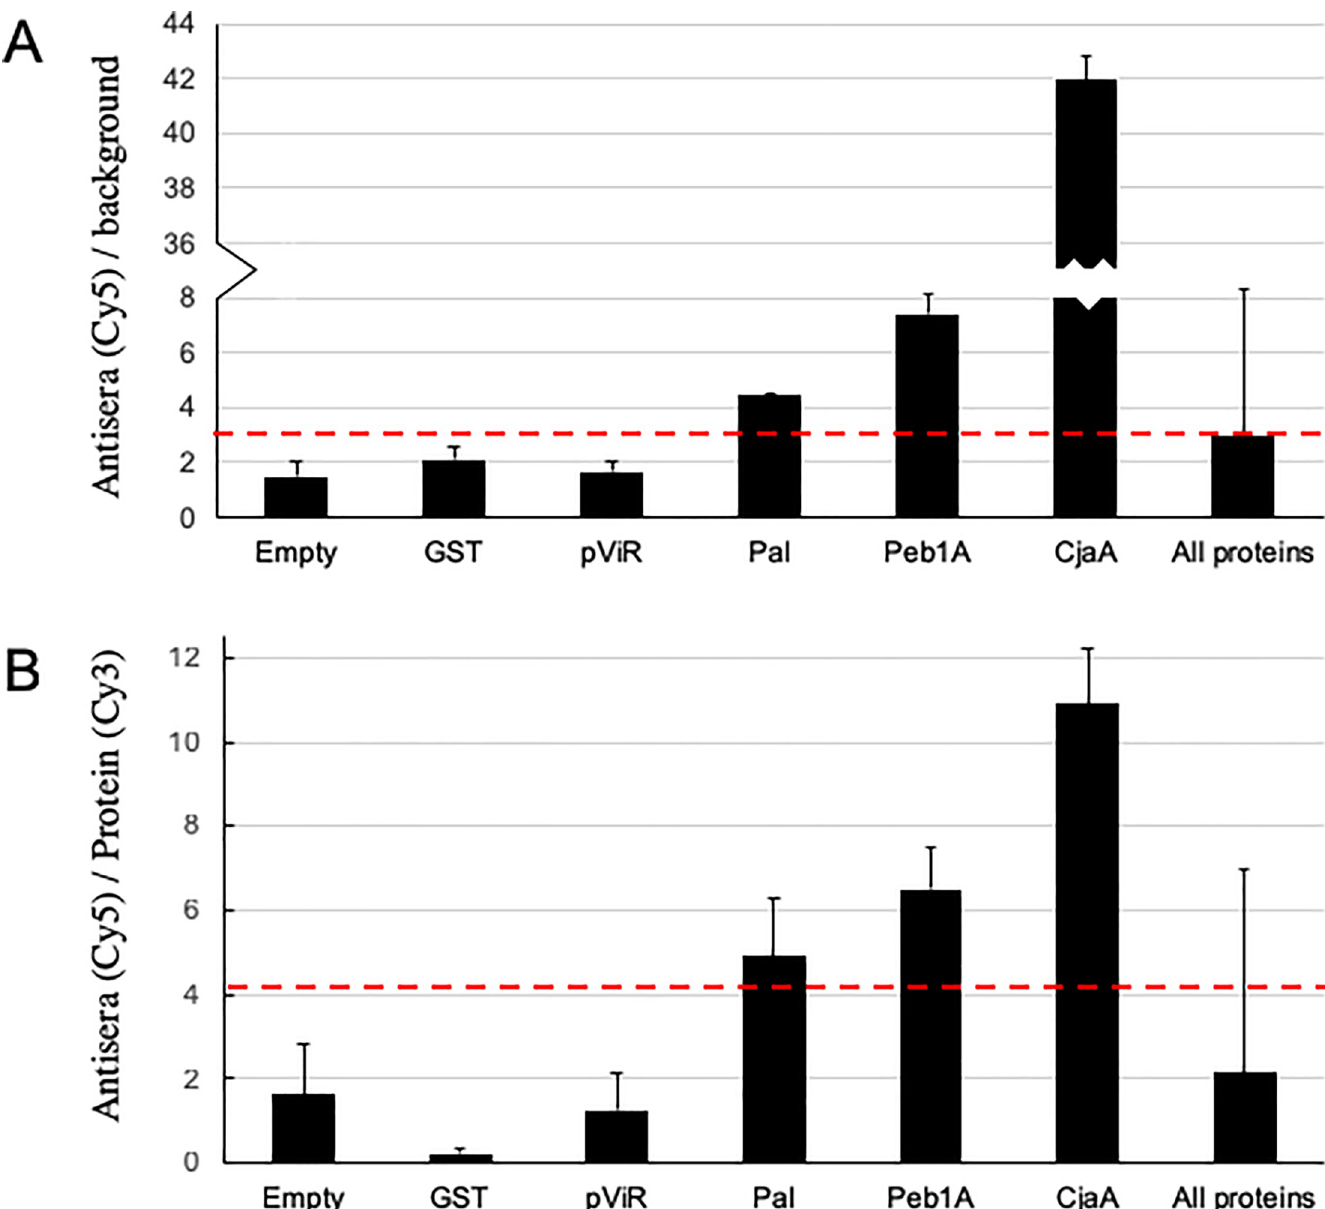
Fig 3. Antigen signals on the microarray. (A ) The mean ratio (Fib) of anti-campylobacter antisera staining intensities (Cy5) over background staining for spots with the indicated proteins or blanks. Data are from duplicates of: 60 spots with no added protein (Empty); 3 spots with purified GST (GST); 54 spots with the 54 pVIR proteins (pVIR); spots with Pal, Peb1A, or CjaA; and all spots with the remaining 1413 C . jejuni proteins (All proteins). Error bars are standard deviation. The dotted red line indicates the Fib cut off ( > 3) for antigens. (B) The mean ratio (Fip) of anti-campylobacter antisera staining intensities (Cy5) over GST protein staining (Cy3) for spots with the indicated proteins or blanks as in Fig 3A. Error bars are standard deviation. The dotted red line indicates the Fip cut off ( > 4) for antigens.